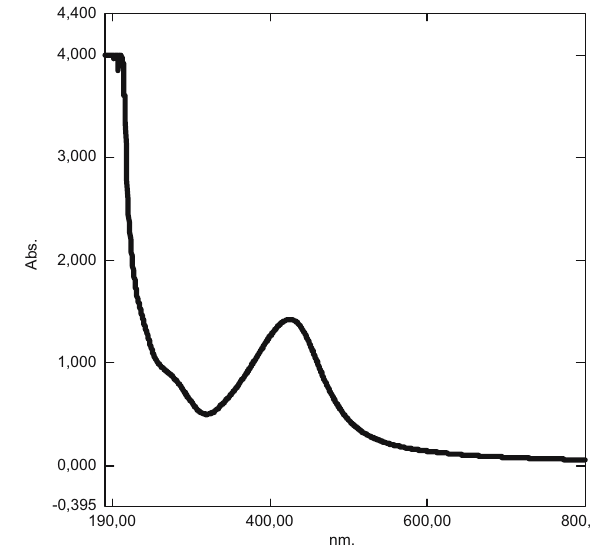
Figure 4: Bioinspired silver nanoparticles spectra prepared by utilizing 1 mL pure T. govanianum extract solution with 9 mL of silver salt ( 0.1 mM ) solution. The sharpest peak of the silver nanoparticles ( AgNPs ) is at 407.98 nm.